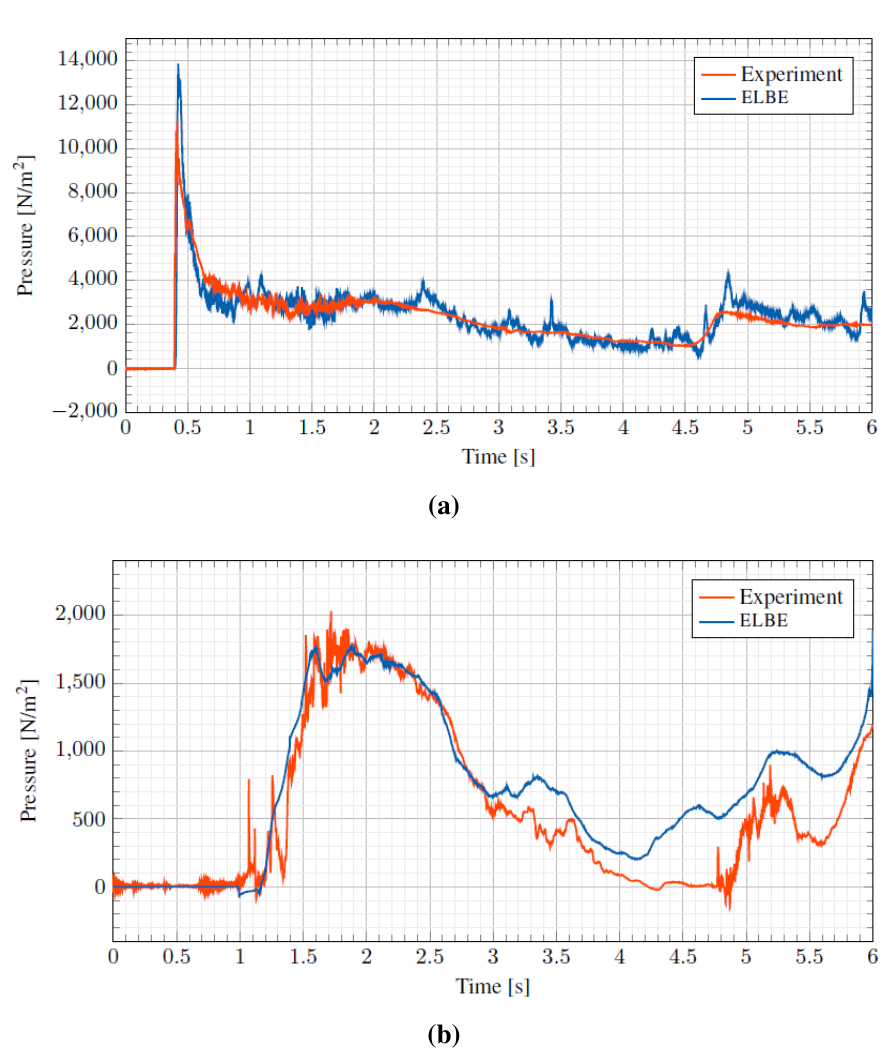
Figure 20. ELBE results for two selected pressure probes, high-resolution simulation with ∆ x ≈ 1 . 56 mm and Mach number Ma = 0 . 1 . ( a ) Pressure probe P1 (low-pass filtered); ( b ) pressure probe P7 (low-pass